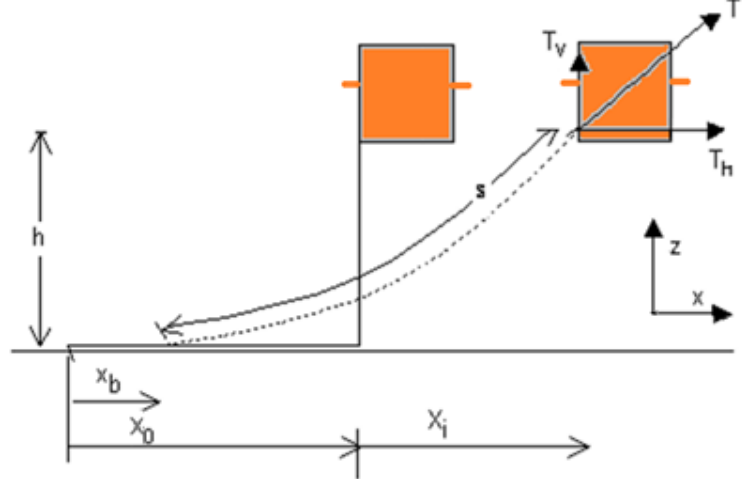
Figure 17. Schematic of Catenary Mooring system of CALM Buoy.